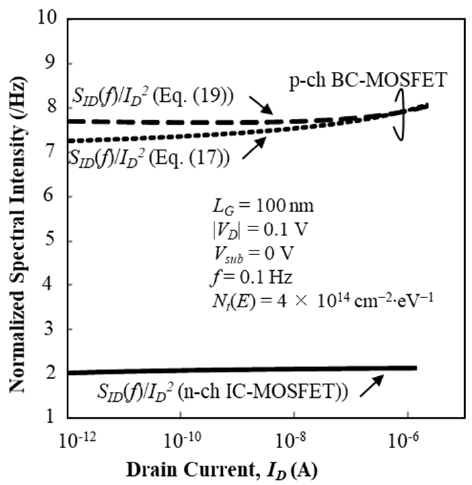
Figure 11. Calculation results of S I assumed N t ( E ) = 4 × 10 14 cm − 2 ∙ eV − 1 and V sub = 0 V.